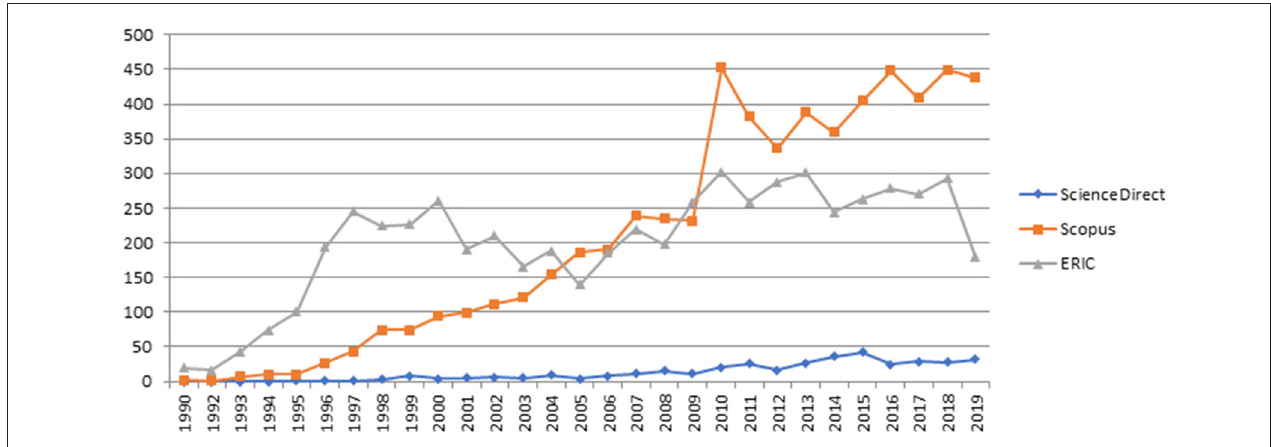
FIGURE 1 | Graphical representation of the graph of the number of publications from 1990 to 2019, after searching for “service-learning” in Science Direct, Education Resources Information Center (ERIC), and Scopus databases. no relation with assessment. The number of excluded results: